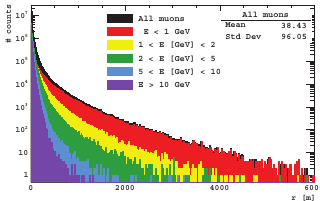
Figure 2. Distance from the shower axis at which muons are produced. The colors represent several ranges for the initial en- ergy muons, namely: black – all energies; red – E i < 1 GeV; yellow – 1 < E i [GeV] < 2; green – 2 < E i [GeV] < 5; blue – 5 < E i [GeV] < 10; violet – E i > 10 GeV.